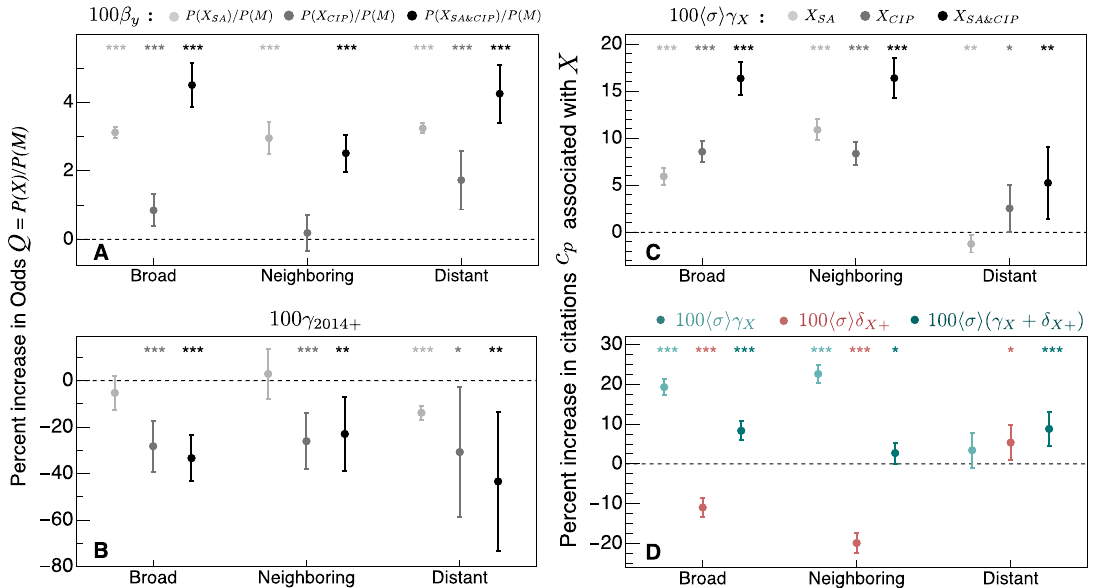
Fig. 5 Propensity for X and citation impact attributable to cross-domain activity at the article level. A The annual growth rate in the likelihood P ( X ) of research having cross-domain attributes represented generically by X . B Decreased likelihood P ( X ) after 2014. C Citation premium estimated as the percent increase in c p attributable to cross-domain mixture X , measured relative to mono-domain (M) research articles representing the counterfactual baseline. Calculated using a researcher fi xed-effect model speci fi cation which accounts for time-independent individual-speci fi c factors; see Tables S4 – S5 for full model estimates. D Difference-in-Difference ( δ X + ) estimate of the "Flagship project effect'' on the citation impact of cross-domain research. Shown are point estimates with a 95% con fi dence interval. Asterisks above each estimate indicate the associated p − value level: * p < 0.05, ** p < 0.01, *** p <